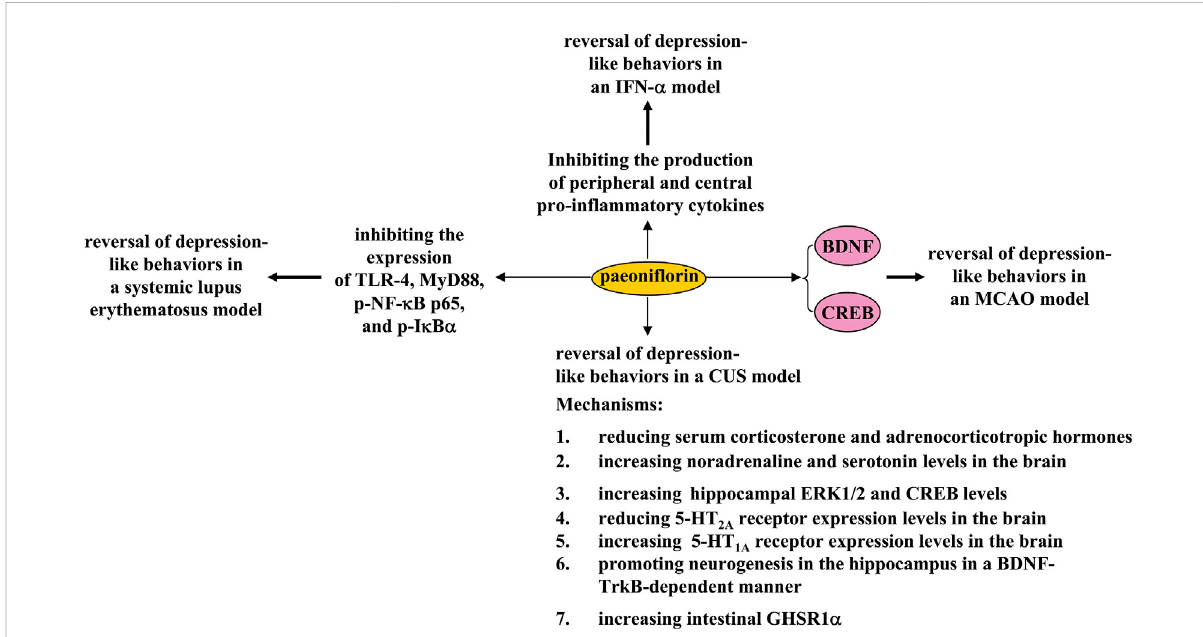
FIGURE 6 Effects and mechanisms of paeoni fl orin in depression. Paeoni fl orin administration can reverse 1) CUS-induced depression-like behaviors by reducing serum corticosterone and adrenocorticotropic hormone levels, increasing brain noradrenaline and serotonin levels, increasing hippocampal ERK1/2 and CREB levels, reducing 5-HT 2A receptor expression levels in the brain, increasing brain 5-HT 1A receptor expression levels, promotinghippocampalneurogenesisinaBDNF-TrkB-dependentmanner,orincreasingintestinalGHSR1a;2)MCAO-induceddepression-like behaviors by enhancing CREB-BDNF signaling; 3) systemic lupus erythematosus-induced depression-like behaviors by inhibiting the expression of TLR-4,MyD88,p-NF- κ Bp65,andp-I κ B α ;and4)IFN- α -induceddepression-likebehaviorsbyinhibitingtheproductionofperipheralandcentralpro- in fl ammatory